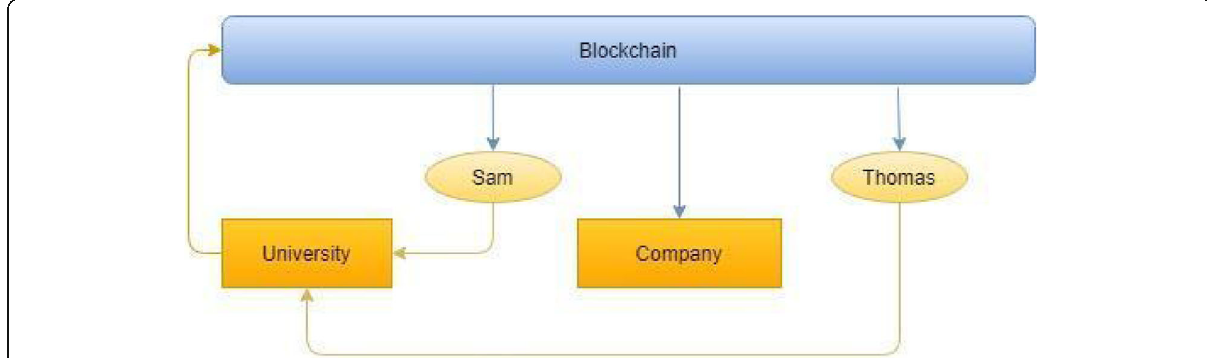
Fig. 1 Describing the role of the stakeholders and their interaction in the proposed system. Sam and Thomas are university